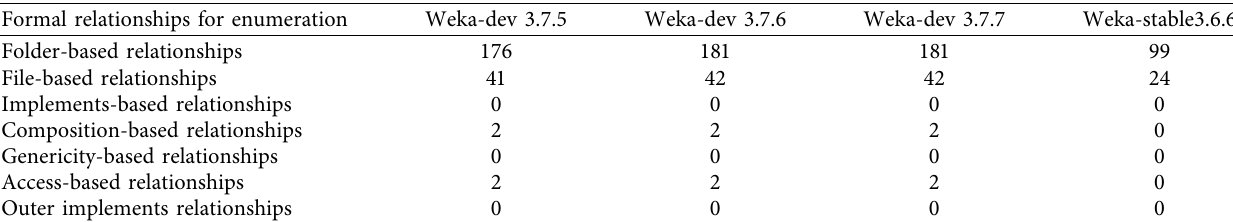
Table 26: Formal relationships for enum in